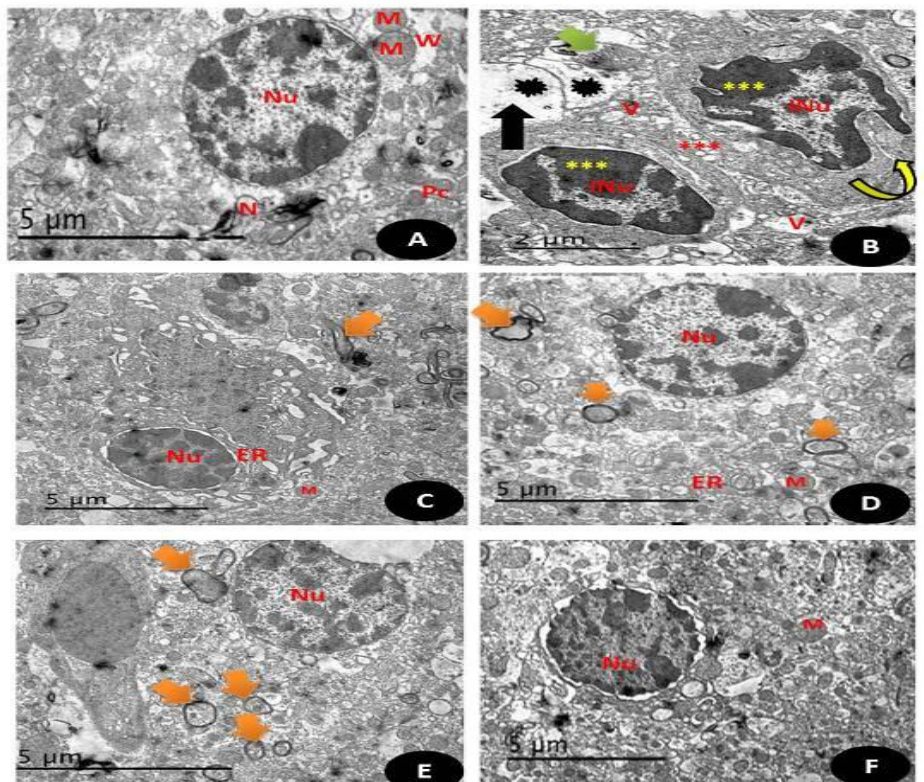
Figure 17. Electron micrographs of a section in the cerebral cortex of: ( A ) control group: normal appearance of white matter of the brain (W) and normal nucleus (Nu) with homogenous distribution of the chromatin, normal size for mitochondria (M), well defined neurons (N) and appearance of well-defined composition of Purkinje cells with well cytological compositions (PC)(Scale bar = 5 µ m). ( B ) (DG) group: showing cytoplasm of nerve cell with irregular nuclei (N) with irregular condensed chromatin with irregular and discontinuous myelin sheath (curved arrow), condensed mitochondria with partial loss of their cristae (Green arrow) with enlarged spaced endoplasmic reticulum (rER) with markedly enlarged processes of astrocytes (Red ***) with karyolysed nuclei and apoptotic appearance with irregular boundaries and convolution of the nuclear envelop with disintegration of unclear chromatin (Yellow ***) with some unmylaniated neurons (Black arrow) (Scale bar = 5 µ m). ( C ) (Q) group showing normal appearance of brain tissues with mylinated neurons (Orange arrows), with normal regular boundaries nucleus (Nu) with normal endoplasmic reticulum (ER) and moderate sized mitochondria (M) (Scale bar = 5 µ m). ( D ) (Ru III /Q) group showing normal appearance of brain tissues with mylinated neurons (Orange arrows), with normal regular boundaries nucleus (Nu) with normal endoplasmic reticulum (ER) and moderate sized mitochondria (M) (Scale bar = 5 µ m). ( E ) (DG + Q) treated group showing restoration regular boundaries of the nucleus (Nu) with restoration of most of the mylinated neurons (Orange arrow) with still some swelling areas (Scale bar = 5 µ m). ( F ) (DG + Ru III /Q) treated group showing high restoration of the normal appearance of neural cells that Q alone, with complete round regular nuclear boundaries (Nu), with normal sized mitochondria (M) and normal sized neurons (Scale bar = 5 µ